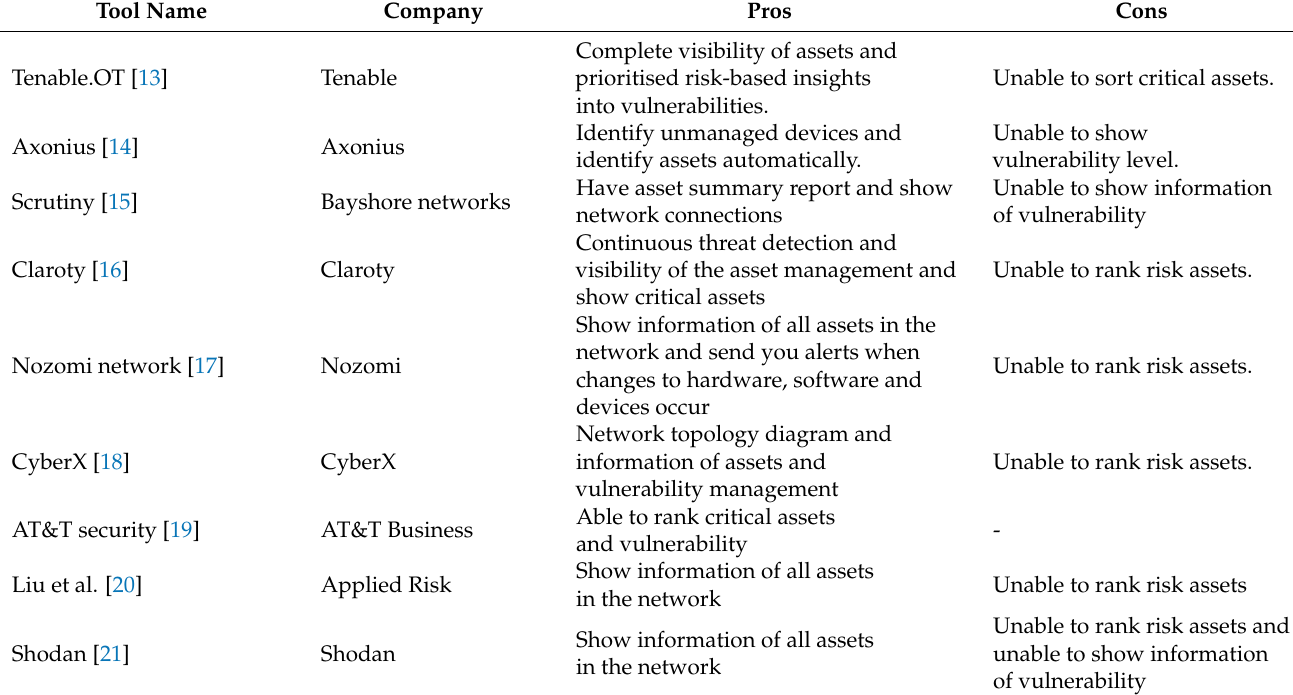
Table 1. Existing Tools for Asset Discovery in